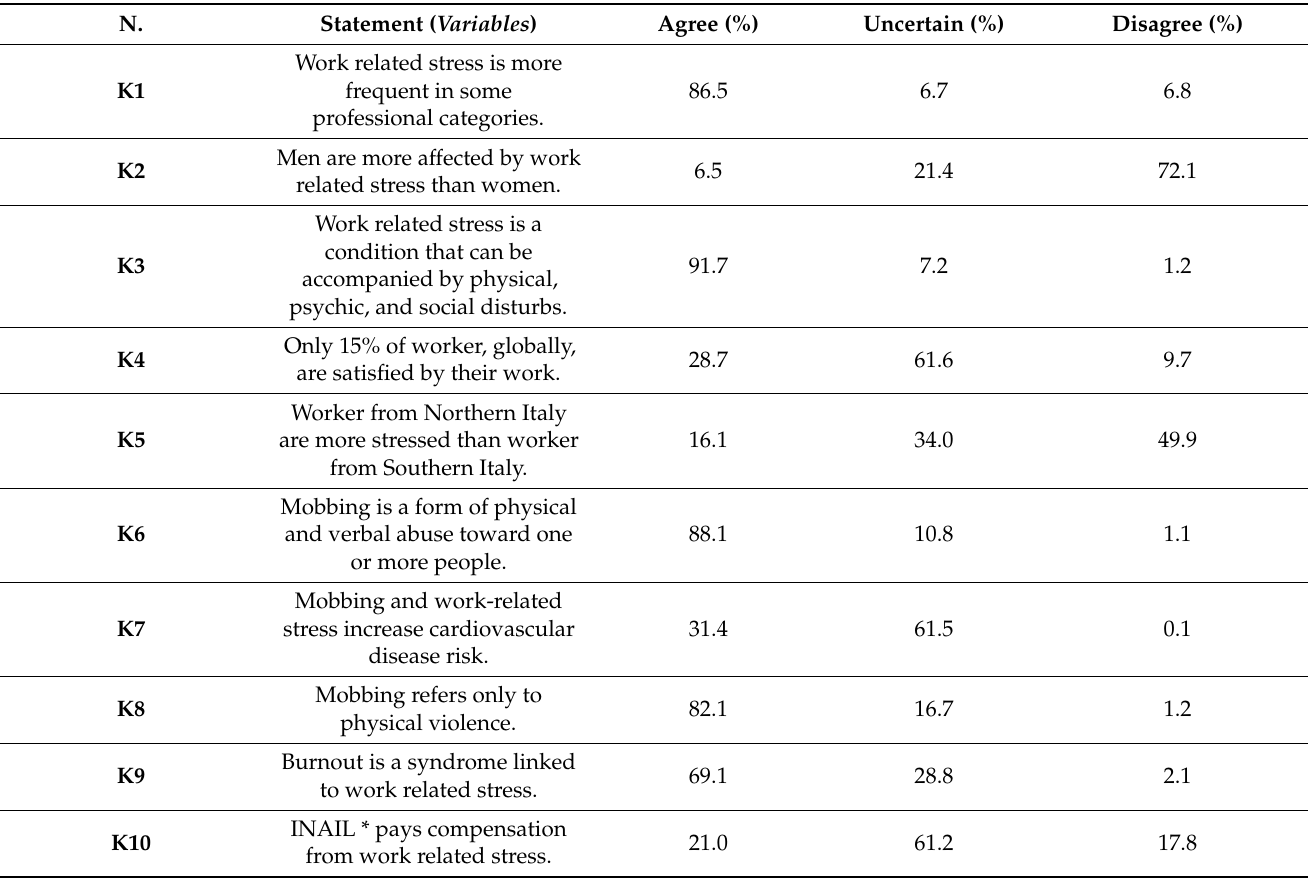
Table 2. Knowledge of respondents toward job